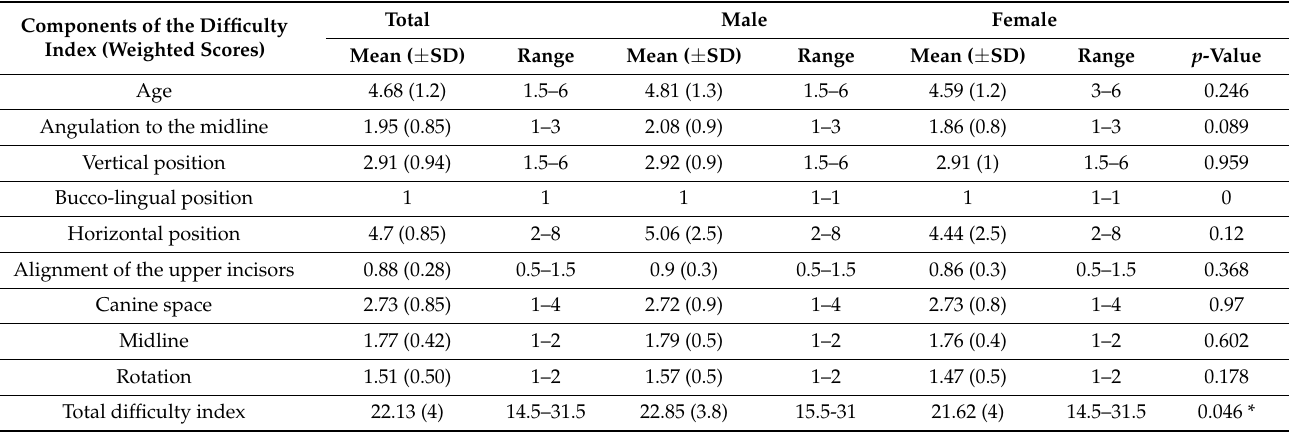
Table 4. Comparison of the components of the difficulty index between male and female study subjects using an independent t -test (N =